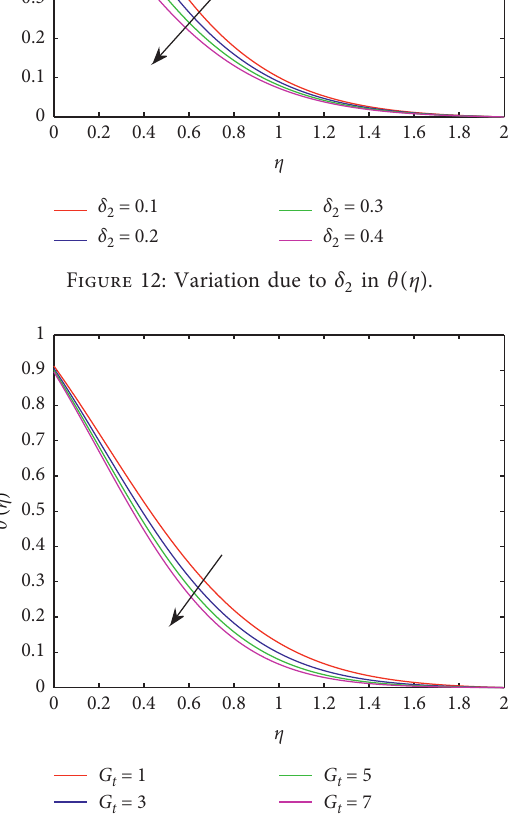
Figure 13: Variation due to G